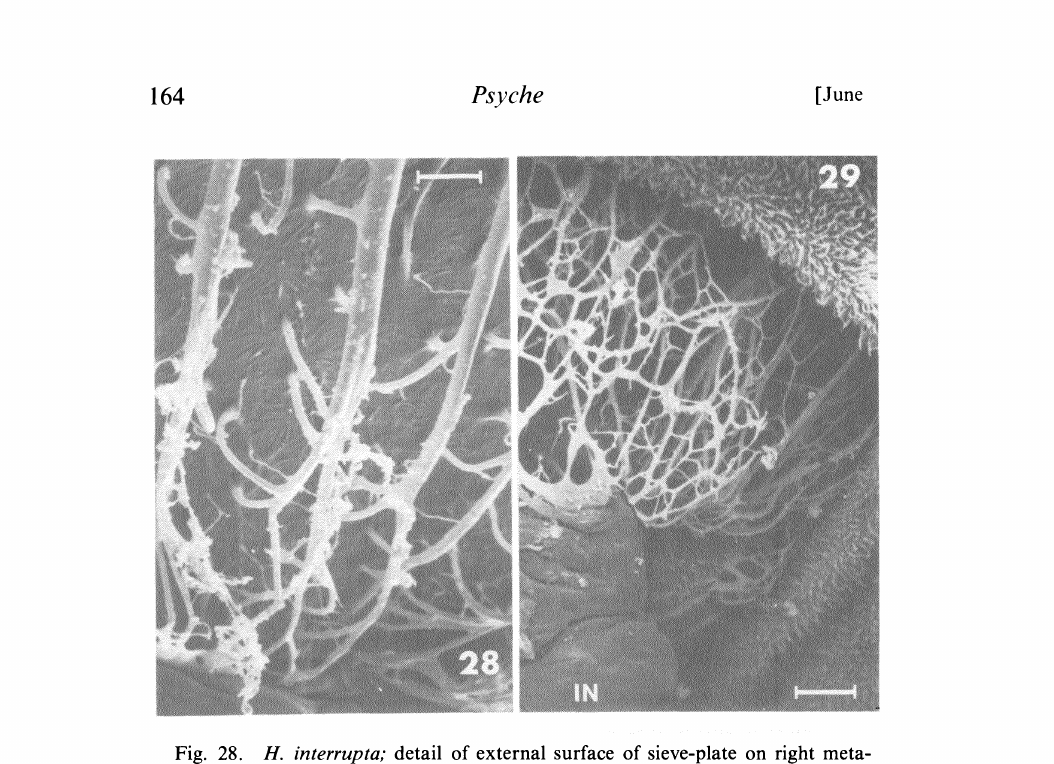
Fig. 28. H. interrupta; detail of external surface of sieve-plate on right meta- thoracic spiracle. Branching trabeculae are connected by short struts to an inner membrane which bears pinnately-arranged narrow slits. Dorsal margin of integu- mental region appears at extreme lower left. Top of figure is dorsal, right side is anterior. Scale line 10 #m. Fig. 29. D. zealandiae; external surface of anterodorsal part of metathoracic spiracle, oriented as in Fig. 25. Sieve-plate bears branching trabeculae; inner mem- brane is too deep to be visible. Surface of mesothoracic epimeron (upper and lower right) is covered with short hydrofuge hairs. IN integumental region of spiracle, with irregular folds. Top of figure is dorsal, right side is anterior. Scale line 10